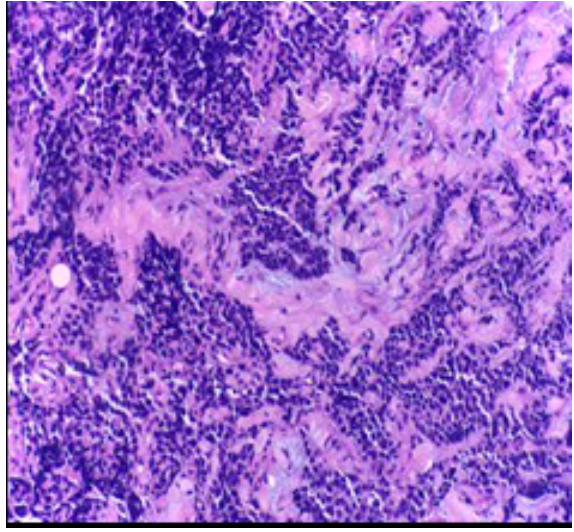
Figure 3. High power view of the neoplastic malignant cells.